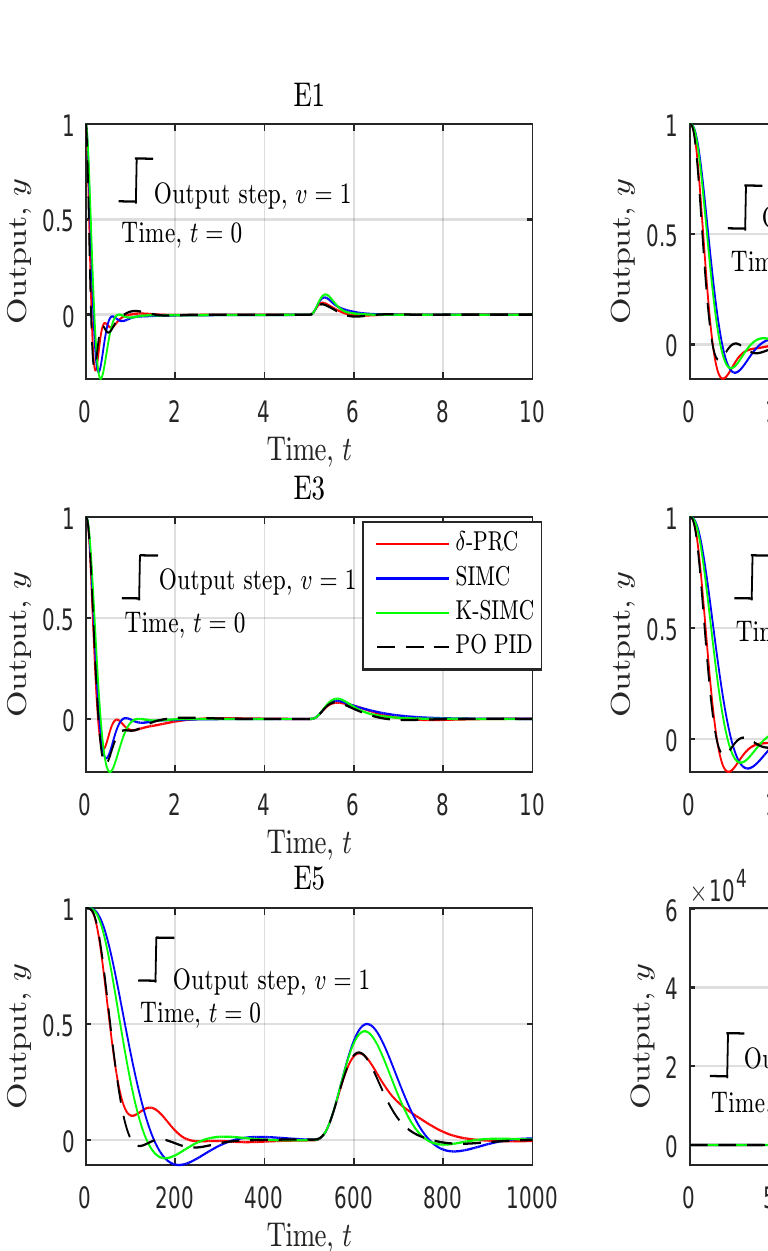
Figure 7: Es1-6. The figure illustrates the output and input step time-domain responses for a pre- scribed robustness, M s = 1 . 59, for the fol- lowing methods: δ -PRC, SIMC, K-SIMC and PO